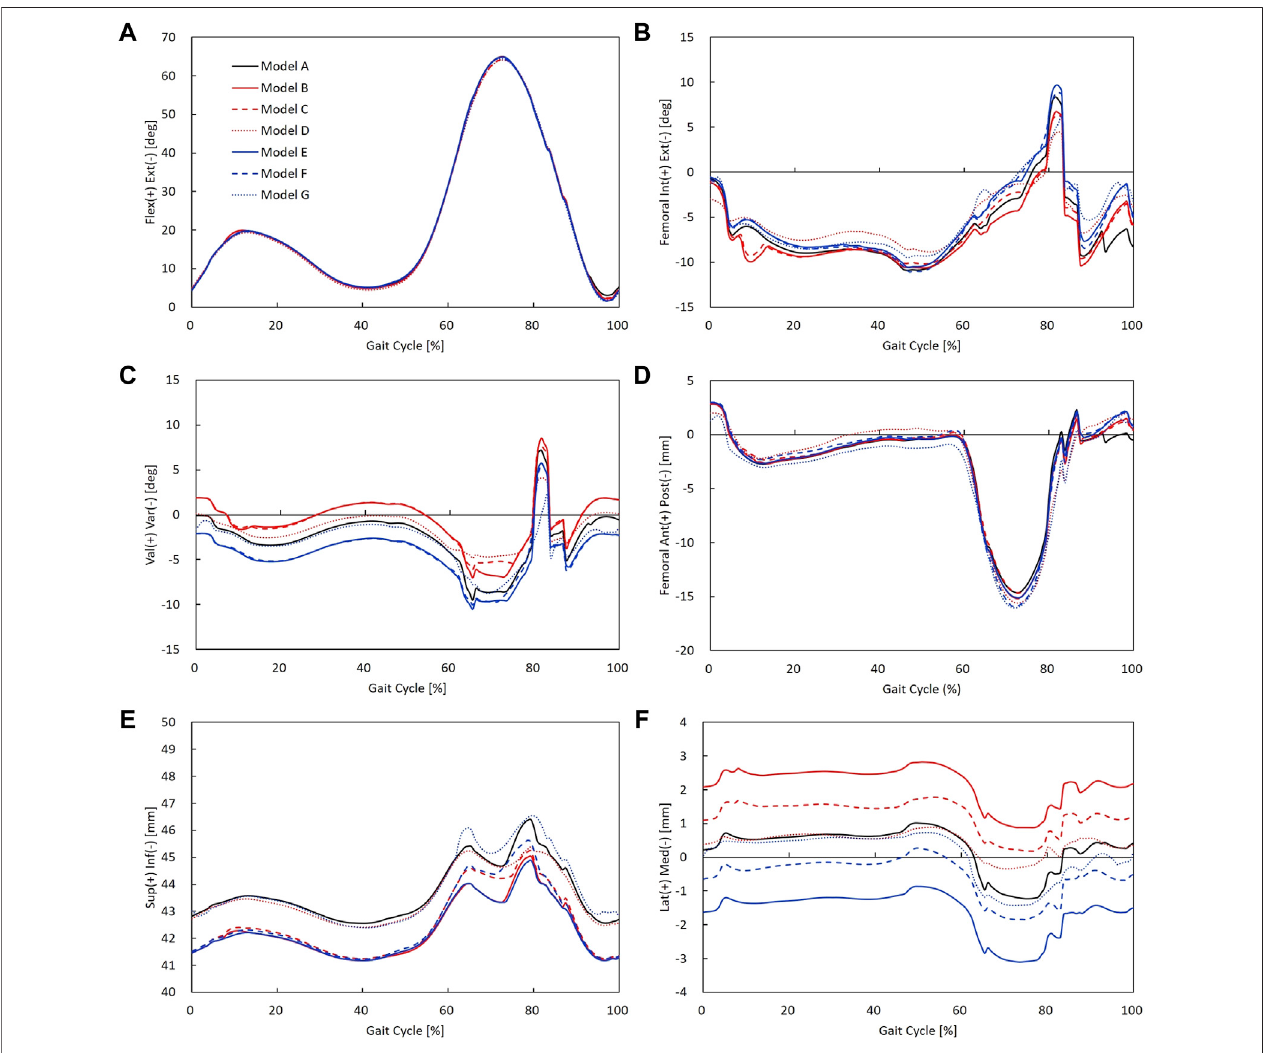
FIGURE 8 | Rotational and translational knee kinematics in models A – G: (A) knee fl exion angle, (B) femoral internal/external rotation, (C) knee varus/valgus angle, (D) femoral anterior/posterior translation, (E) superior/inferior translation (the initial value of superior – inferior translation indicates superior – inferior height difference between the tibial and femoral coordinate systems), and (F) femoral medial/lateral translation.